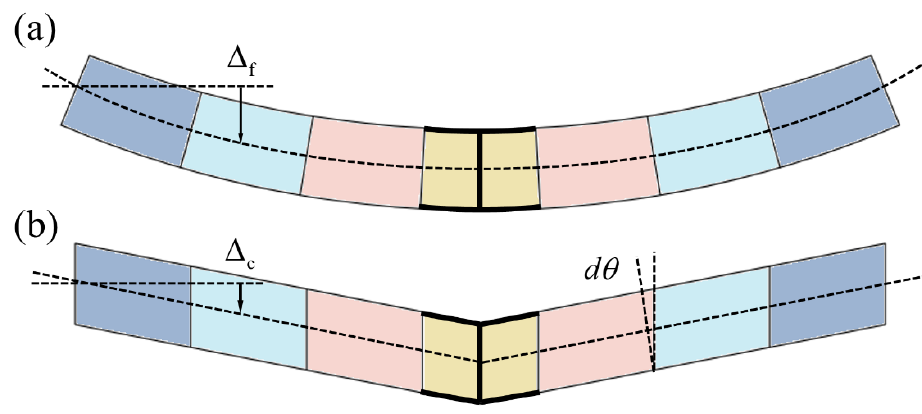
Figure 8. Deformation sketch of sheet metal ( a ) and lattice core ( b ).